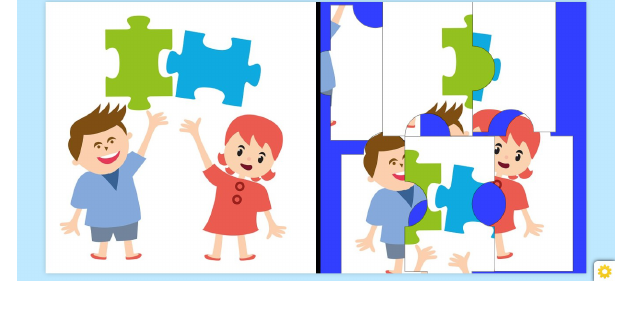
Figure 8. AdaptaQuebra­Cabeca’s startup screen with preview of the image and available